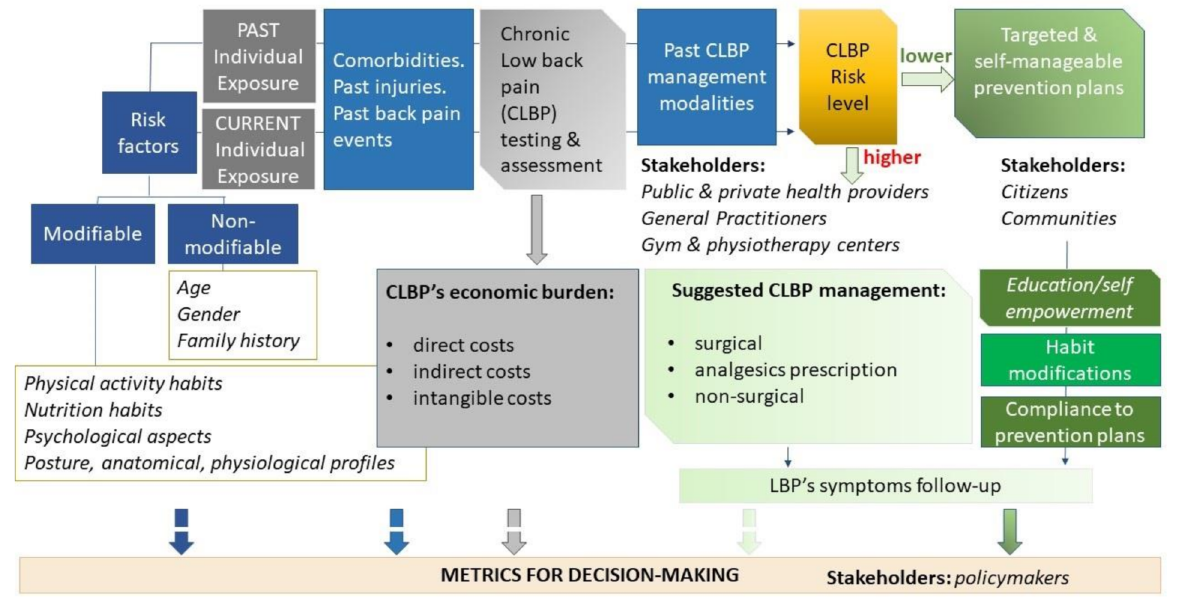
Figure 3. The reference conceptual model proposed for the